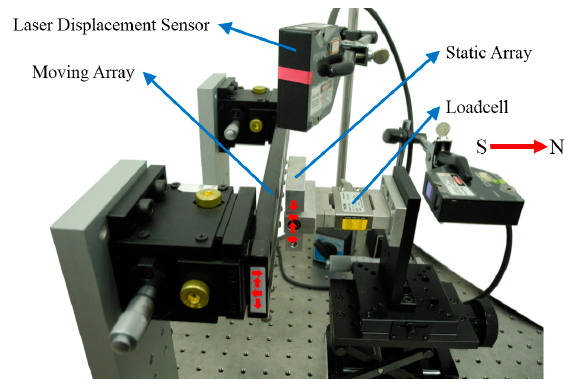
Figure 8. The setup of measurement for a passive magnetic unit.